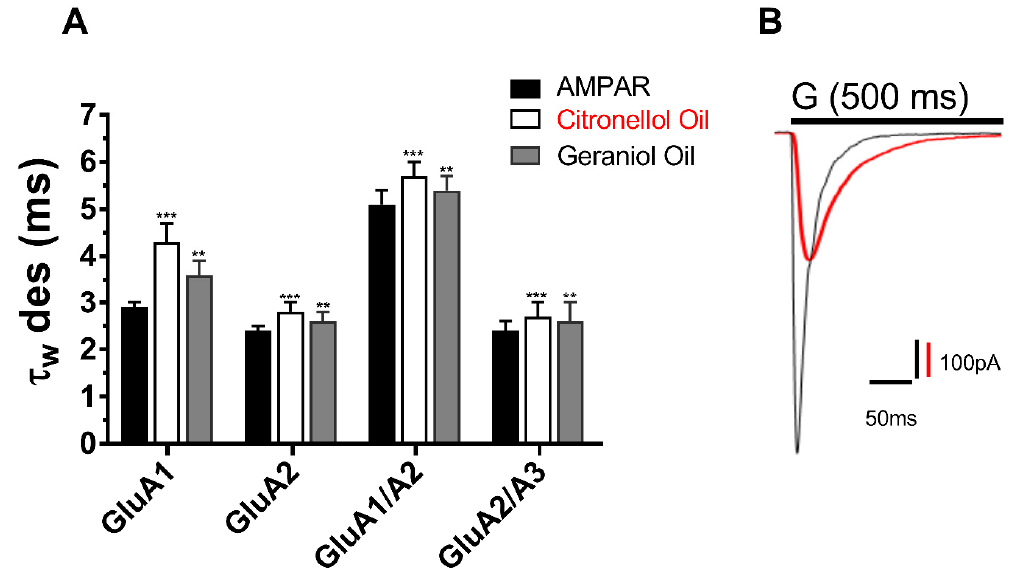
Figure 2. E ff ect of oils and compounds on AMPAR desensitization. ( A ). Desensitization from glutamate alone (black), glutamate + Citronellol (white) and from glutamate + Geraniol (grey). ( B ). Pair of representative whole-cell current traces from GluA1 channels (most significant) expressed in HEK-293 cells in the absence (left) and presence (right) of Citronellol oil. The recording was conducted upon 500 ms application of 10 mM glutamate to whole-cell recording from HEK293 cells expressing various AMPARs subunits. Data shown are mean ± SEM; n = 4 (number of patch cells in the whole-cell configuration). A one-way ANOVA test was used to measure the significance: * p < 0.05; ** p < 0.01; *** p < 0.001; ns, not significant.